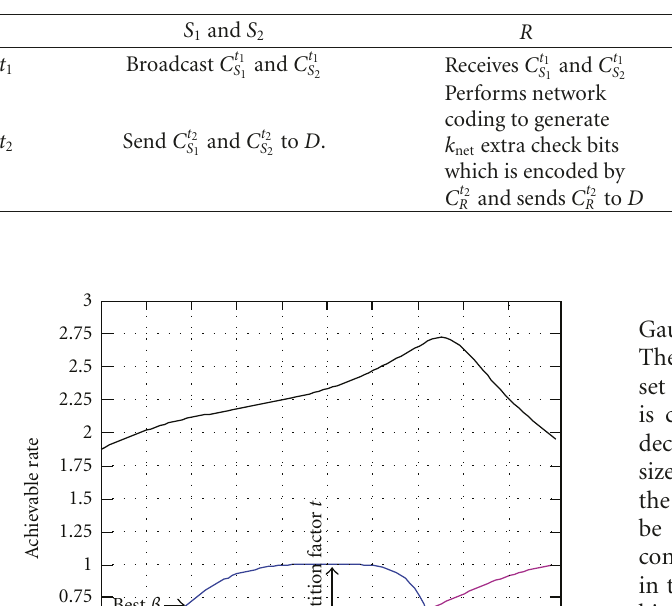
Table 1: The network-coded cooperative strategy.